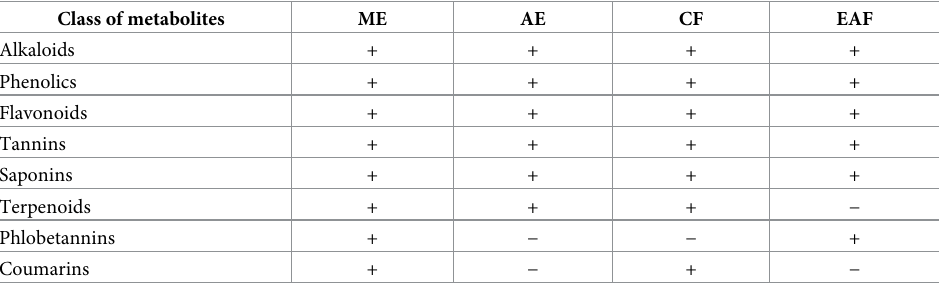
Table 1. Presence/absence of major phytochemical groups in J . mimosifolia leaf extracts and fractions. Class of metabolites ME AE CF EAF Alkaloids + + + + Phenolics